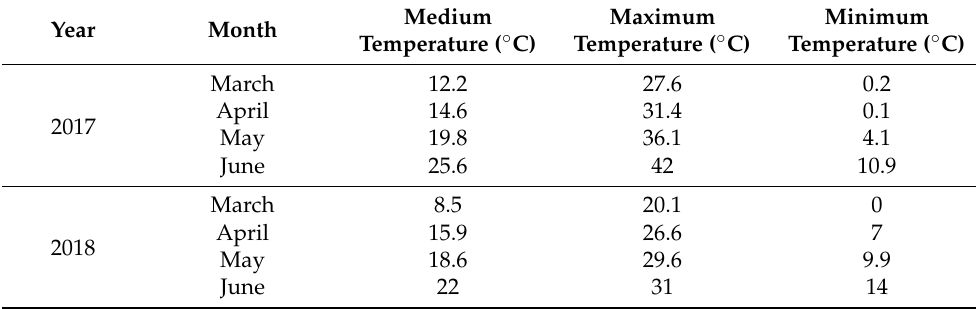
Table 3. Air temperature data, 2017–2018.